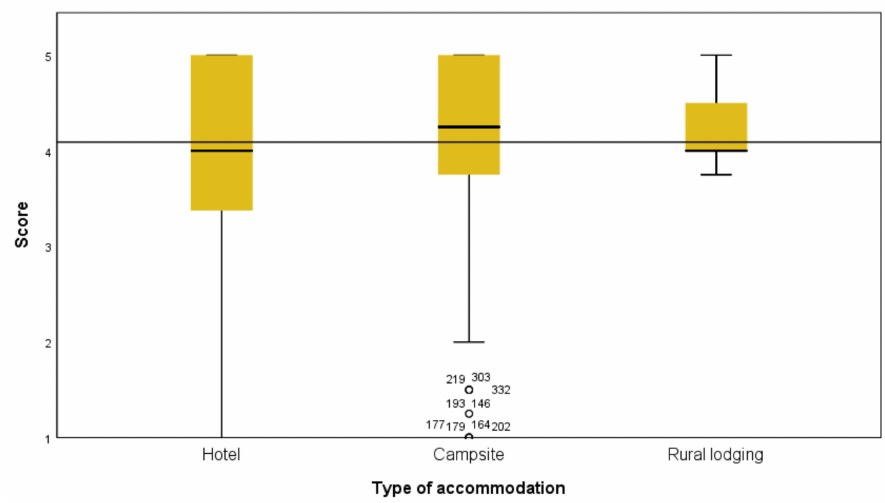
Figure 4. Frequency with which guests engage in water-saving practices by type of accommodation on a scale of 1 (never) to 5